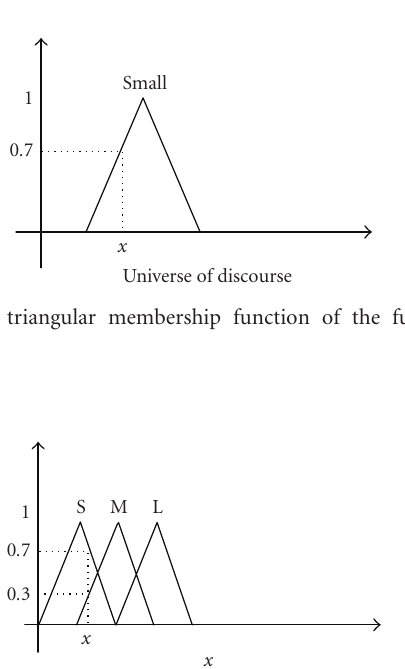
Figure 2: Fuzzy space of the object of Figure 1 that consists of three fuzzy sets: “Small,” “Medium,” and “Large.”